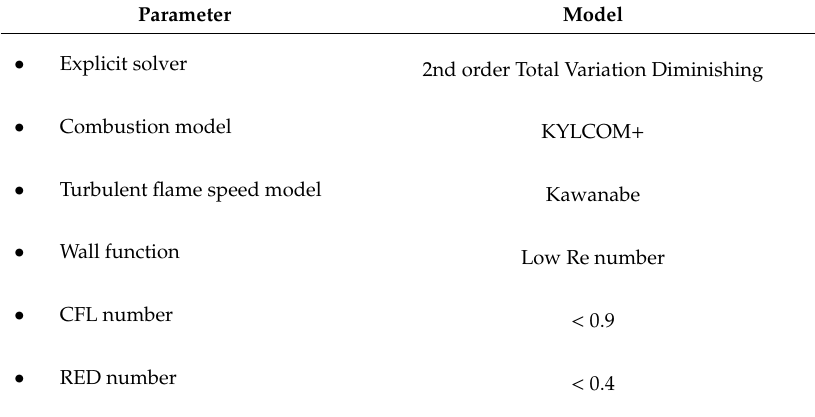
Table 3. Proposed COM3D analysis methodology for the hydrogen flame